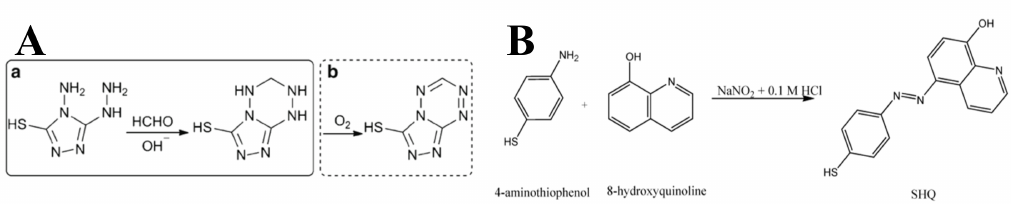
Figure 2. Derivatization reaction of HCHO and 4-amino-5-hydrazino-3-mercapto-1,2,4-triazole (AHMT) under alkaline conditions ( A ) [18]. Synthesis of p-([8-hydroxyquinoline]azo)benzenethiol (SHQ) ( B )